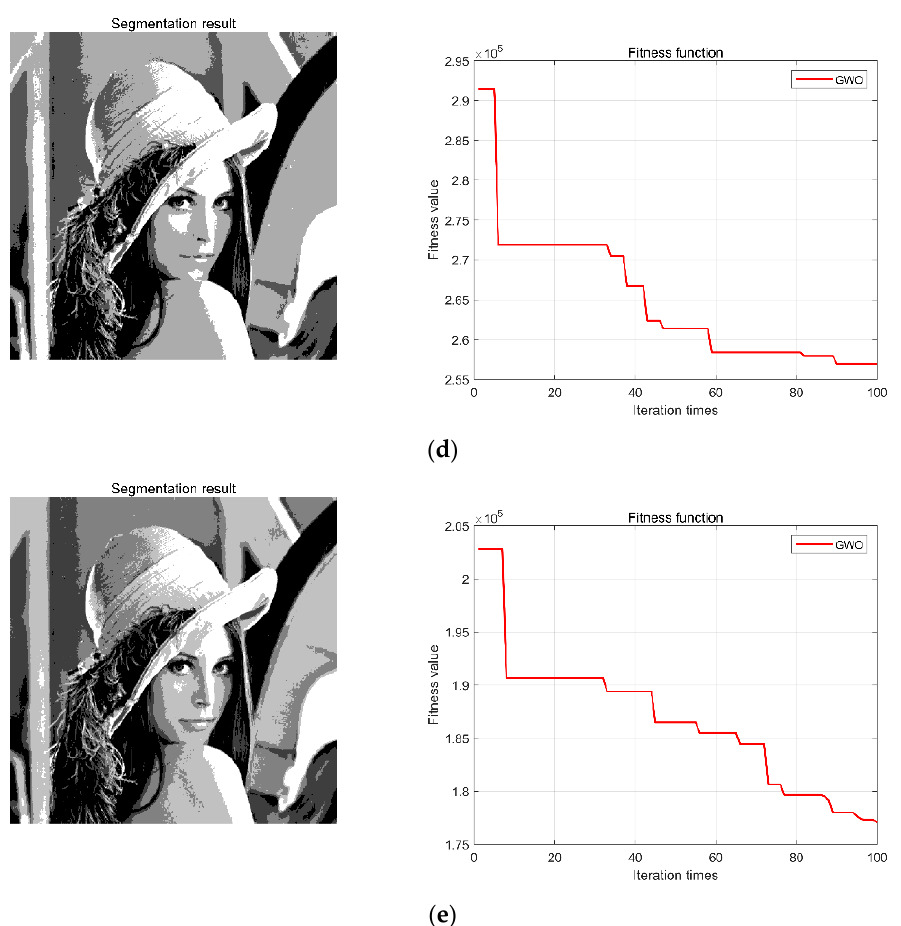
Figure 6. Adaptive multi − threshold segmentation results of the Lena image. ( a ) Lena image; ( b ) single threshold segmentation and GWO iteration results; ( c ) two threshold segmentations and GWO iteration results; ( d ) three threshold segmentations and GWO iteration results; ( e ) four threshold segmentations and GWO iteration results.